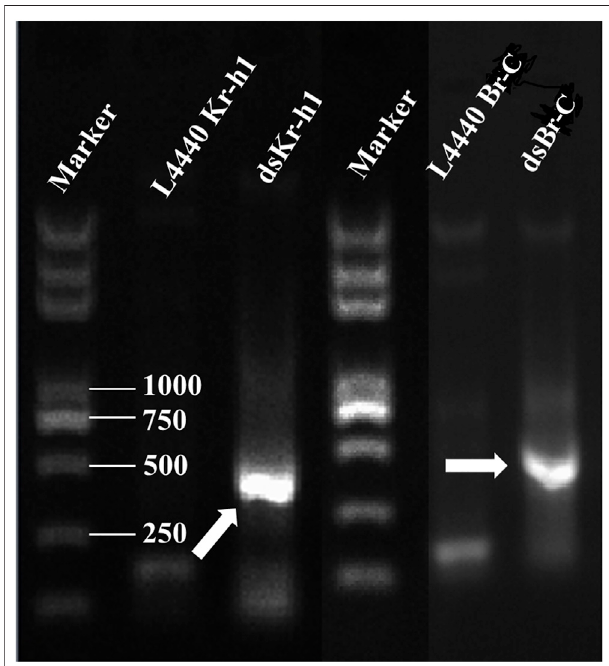
FIGURE 6 | Con fi rmation of dsRNA produced in HT115 cells. The recombinant plasmids were transformed into HT115 competent cells. Individual transformants were cultured on 2 × yeast – tryptone media with additionofisopropyl β - D -1-thiogalactopyranoside.Thecellcultureswere